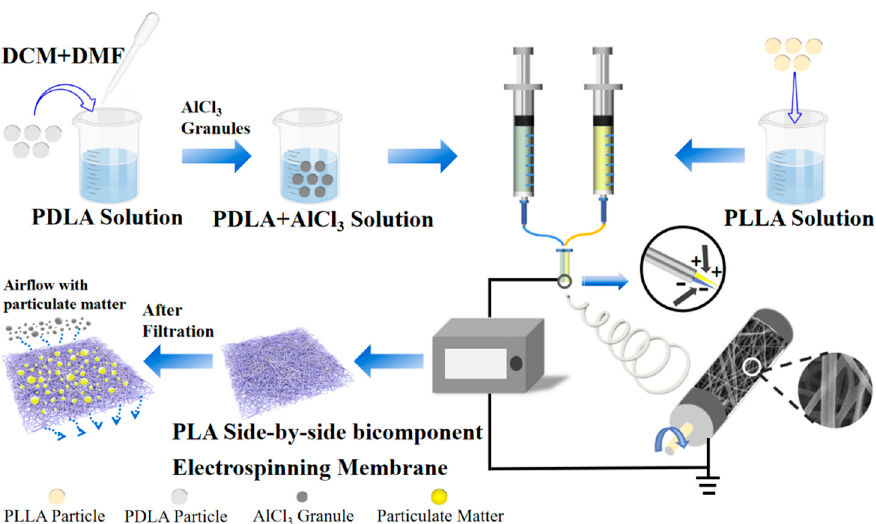
Figure 1. Schematic diagram of side-by-side bicomponent electrospinning nanofibers prepared and membrane surface condition before and after filtration.